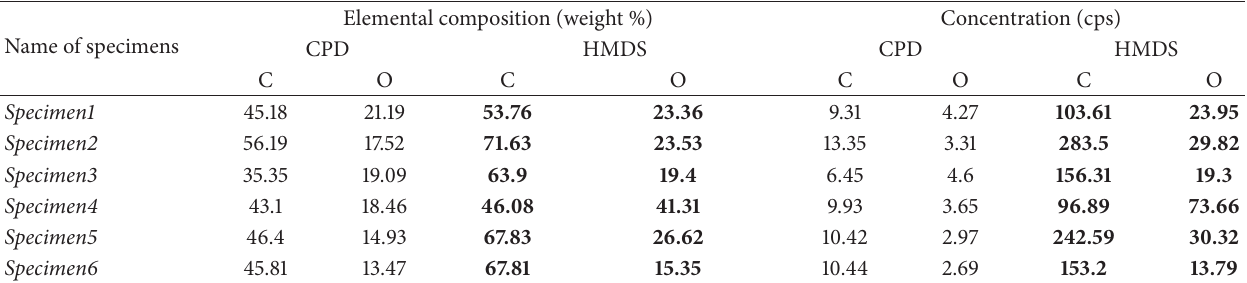
Table 2: Comparison of carbon and oxygen elements based on CPD and HMDS sample preparation techniques in terms of concentration and weight percentage for each